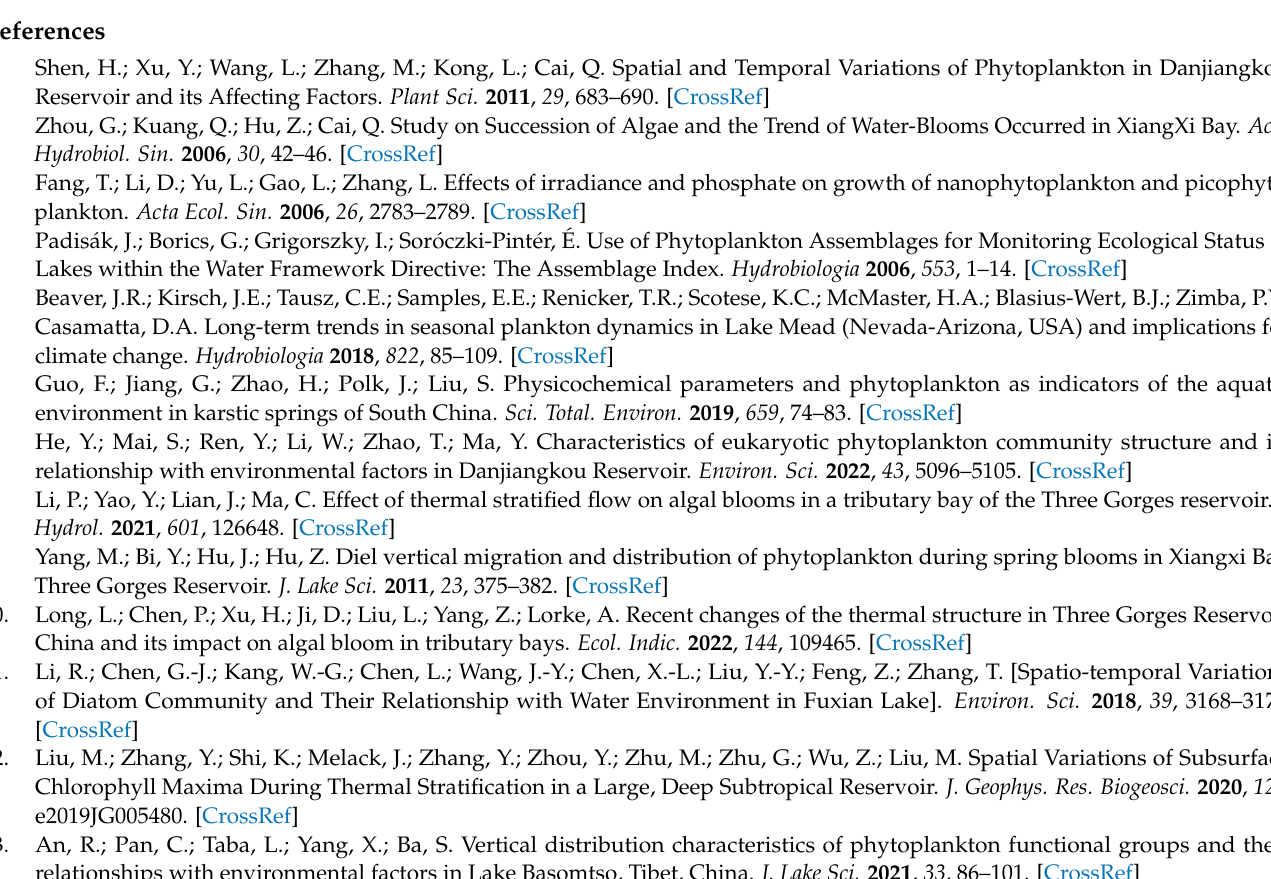
voir. Table S3. Test results of inter-subject effects of diversity indices in the Danjiangkou Reservoir. Figure S1. Variation partitioning of phytoplankton community in the Danjiangkou